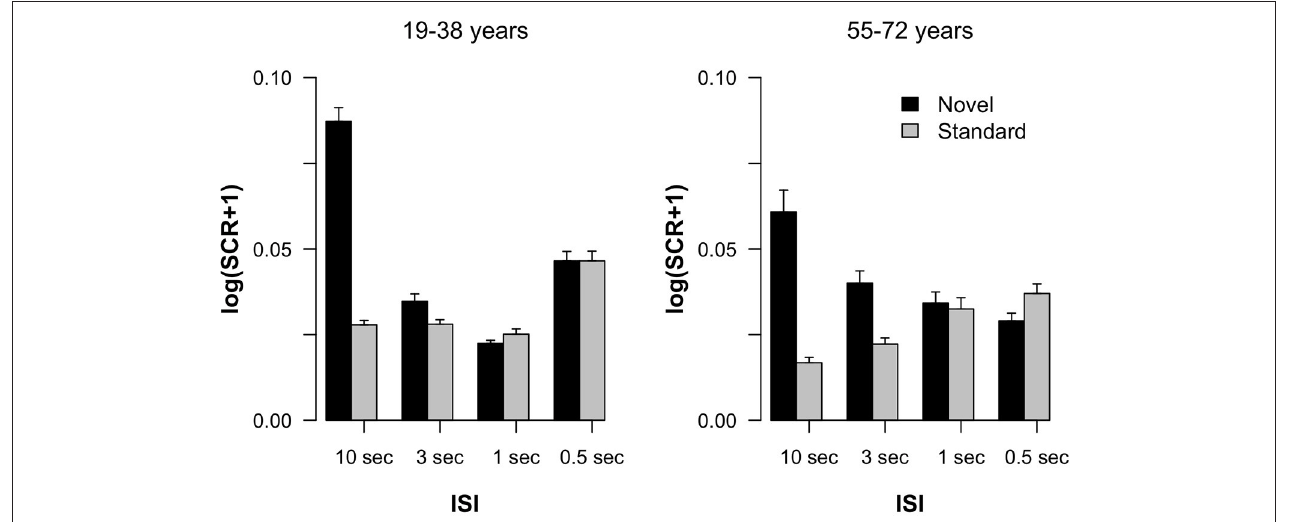
FIGURE 1 | Log-transformed skin conductance response amplitudes in standard and novel trials as a function of ISI, separated for the two groups of participants. Error bars indicate standard errors of the mean.